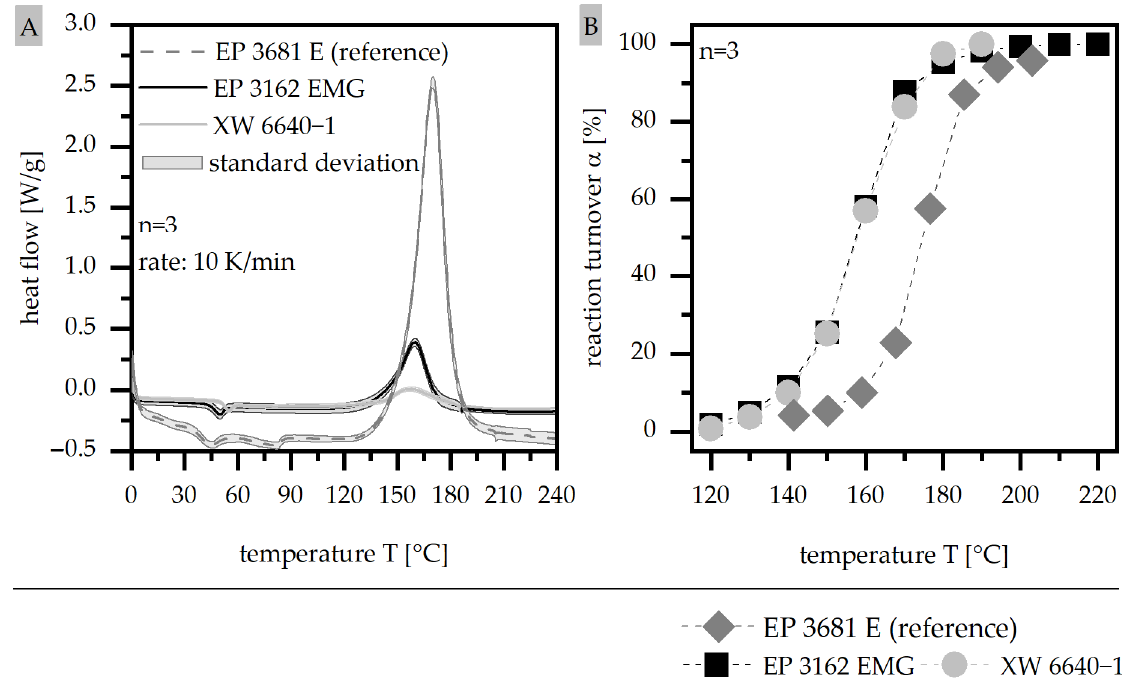
Figure 3. Route of DSC measurements ( A ) and reaction turnover α ( B ) compared for two EP types and the reference material.